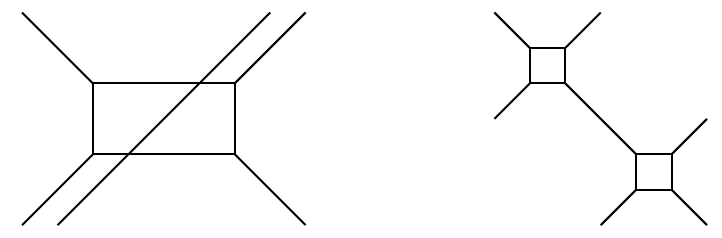
Figure 10. 5-brane web for SU(2) 0 − SU(2) 0 quiver. To read off the theta angles we deform the web on the left to that on the right.